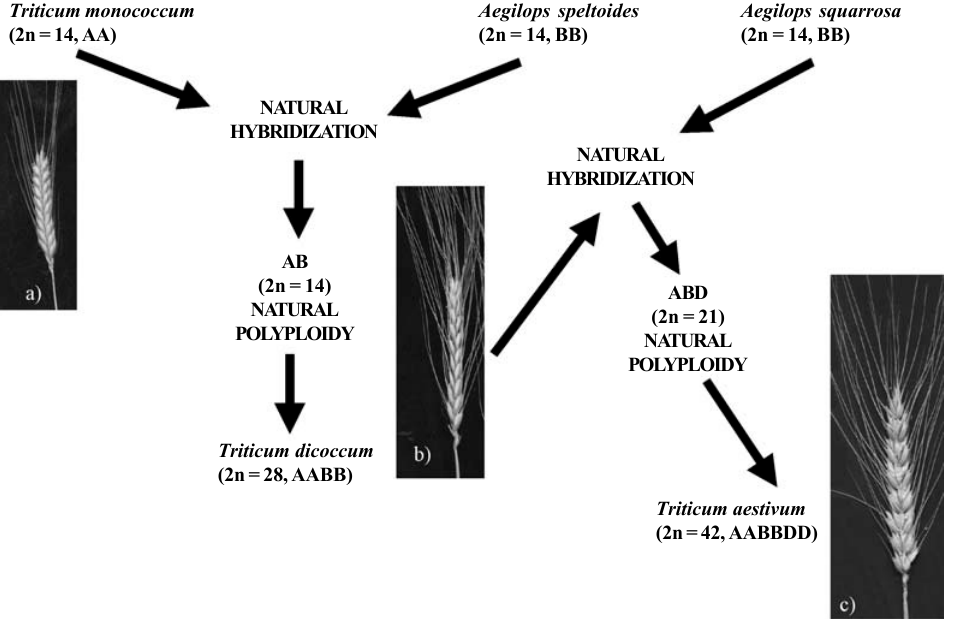
Figure 1 - Synoptic chart of cultivated wheats evolution: the diploid (2n = 14, AA) forms of Triticum monococcum ( a ) were naturally pollinated by weed species, possible Aegilops speltoides (2n = 14, BB?), in about 10,000 B.C. primitive farms. The subsequent genome duplication of hybrids by natural polyploidy gave rise to several wild and cultivated tetraploid species (2n = 28, AABB) like Triticum dicoccum ( b ) and Triticum durum (Figure 2a); again, the natural pollination of the tetraploid T. dicoccum ( b ) by another weed species, Aegilops squarrosa (2n = 14, DD) gave rise to the hexaploid (2n = 42, AABBDD) species ( c